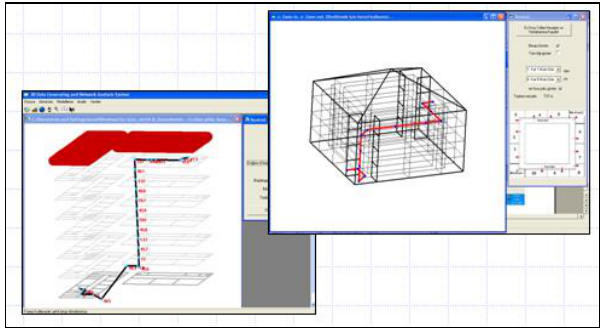
Figure 15. 3D Network Analyze